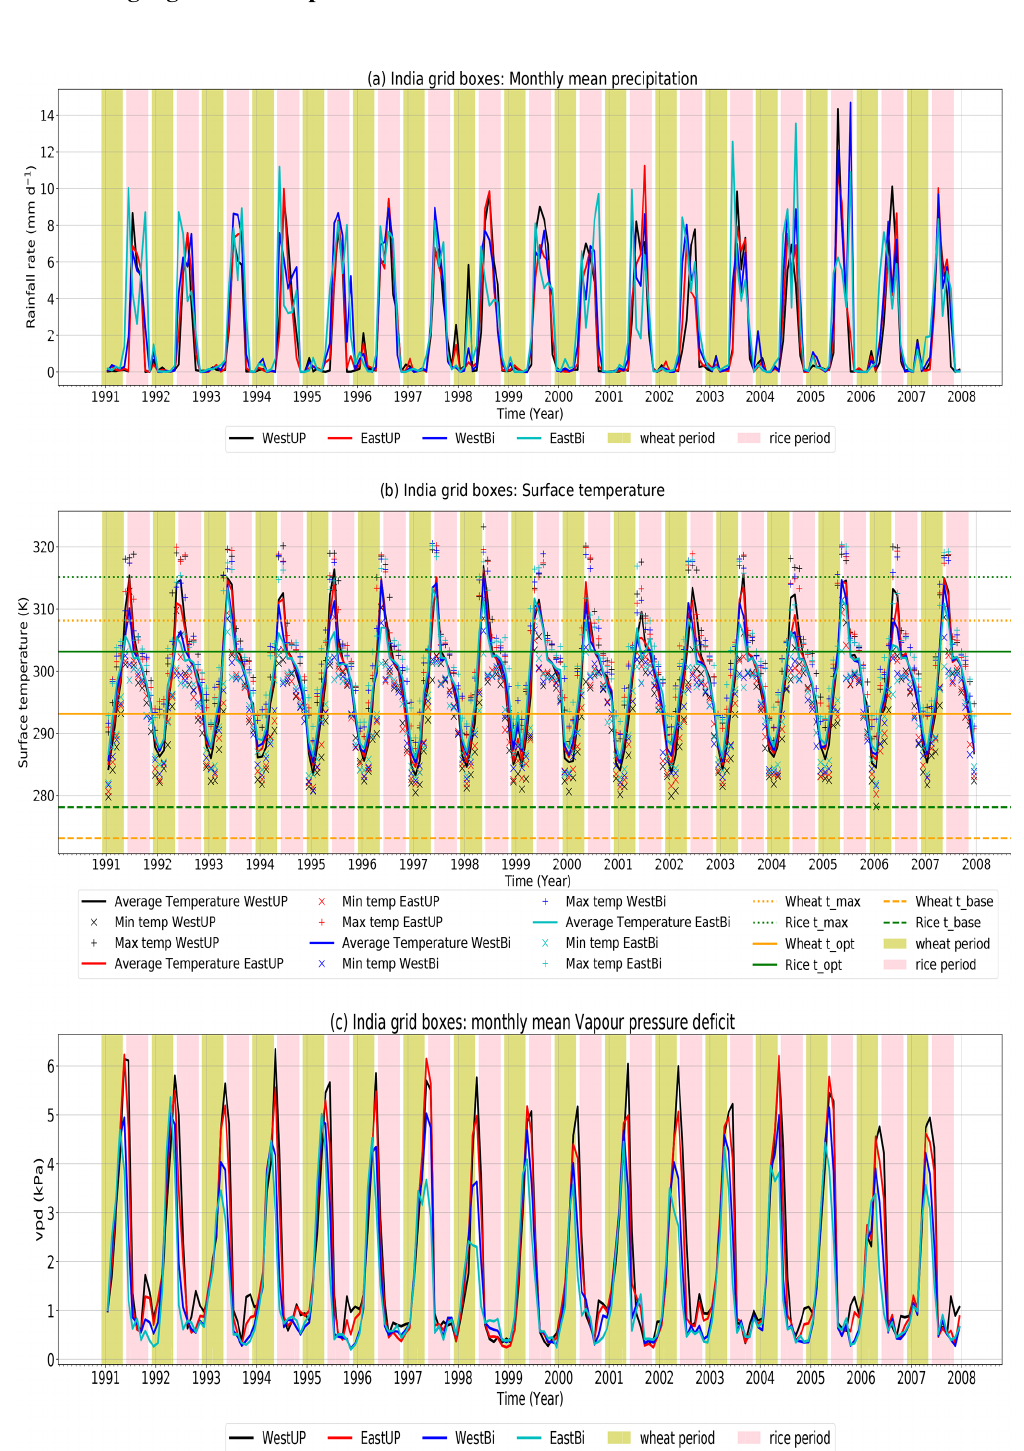
Figure B1. Time series of monthly precipitation (a) , temperature (b) and vapour pressure deficit (c) at each of the India locations shown by the solid lines (WestUP – black, EastUP – red, WestBi – blue and EastBi – cyan). Panel (b) also shows the minimum (“ × ”) and maximum (“ + ”) temperatures for each of the locations for each month together with the JULES cardinal temperatures (horizontal lines) for rice (green) and wheat (orange): max temperatures (dotted line), optimum temperatures (solid line) and base temperatures (dashed line).